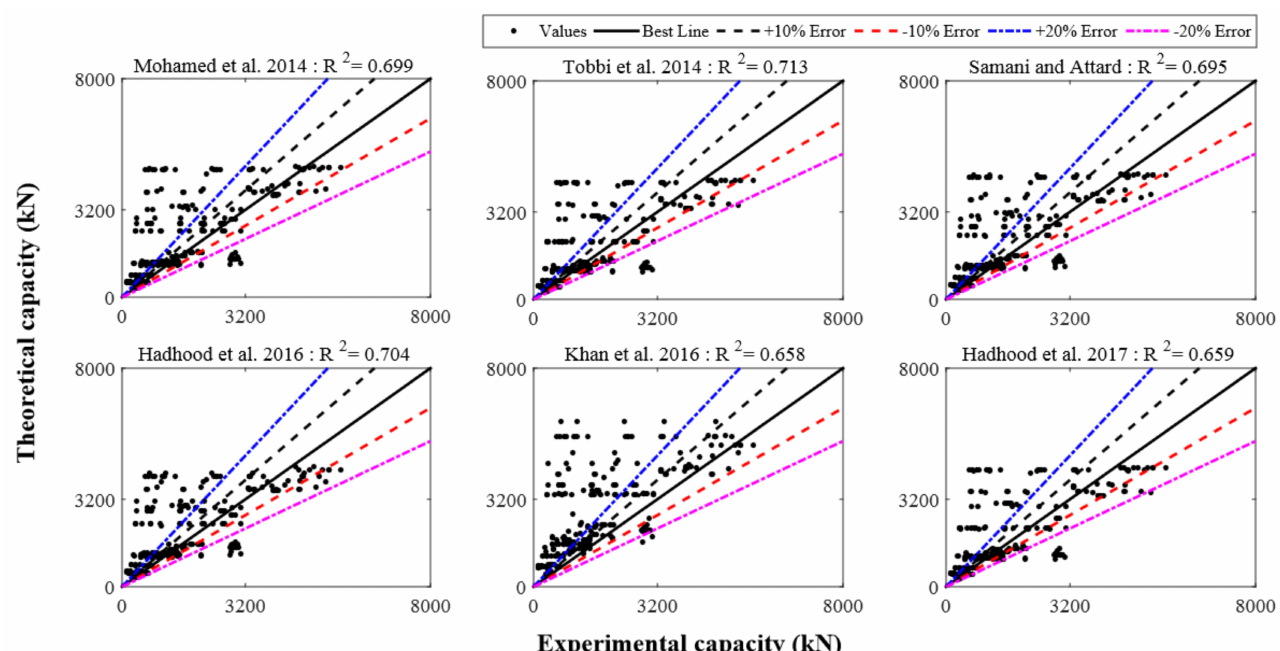
Figure 9. The behavior of existing strength models over the